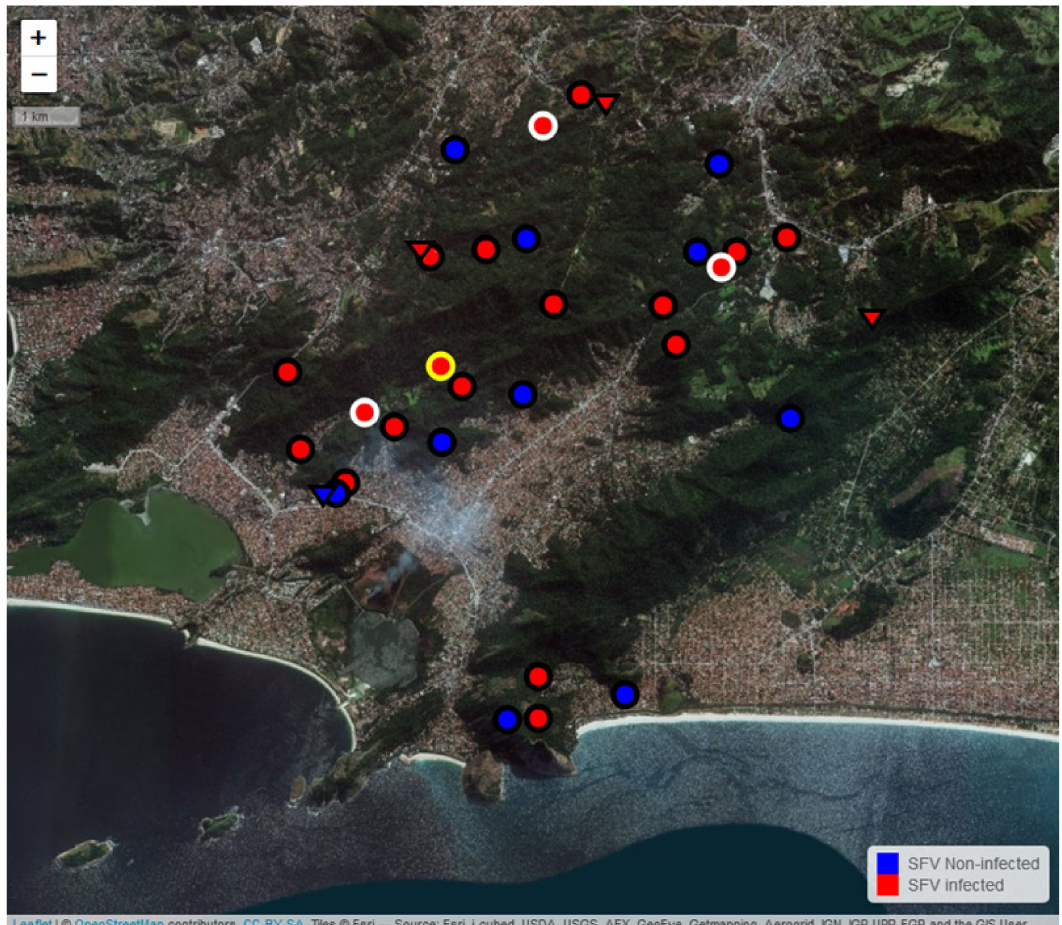
Figure 2. Eco-epidemiology of SFV in the L. chrysomelas family groups in the city of Niteroi / RJ. The location of each L. chrysomelas family group is represented by circles and of solitary animals by triangle. The red color represents infected animals or groups (when at least one animal is infected in the group), while the blue color represents the uninfected animals measured by conventional diagnostic PCR and / or quantitative PCR. Gray halos around the circles depict the presence of the SFVlcm-1 strain, while the yellow halo represents the SFVlcm-2 strain. The absence of halos indicates lack of amplification of the larger pol fragment, not allowing the classification in SFVlcm-1 or